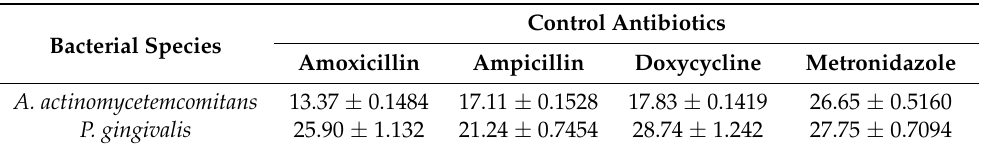
Table 1. Mean values of inhibition zone diameters (expressed in mm ± SD—standard deviation) induced by the control antibiotics on A. actinomycetemcomitans and P. gingivalis . Control Antibiotics Bacterial Species Amoxicillin Ampicillin Doxycycline Metronidazole A. actinomycetemcomitans